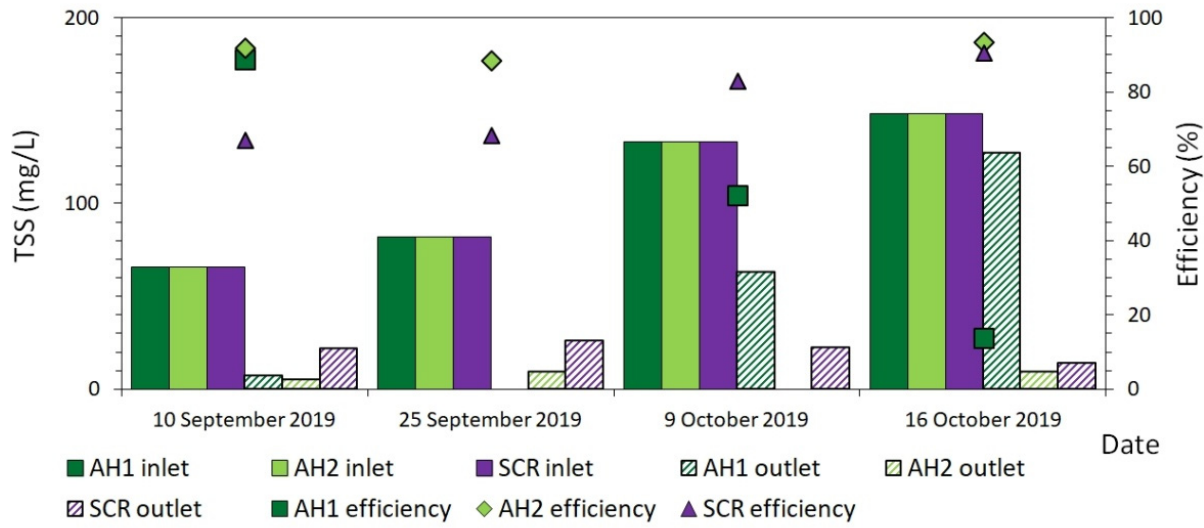
Figure 11. Inlet and outlet TSS and removal efficiencies at stage I.